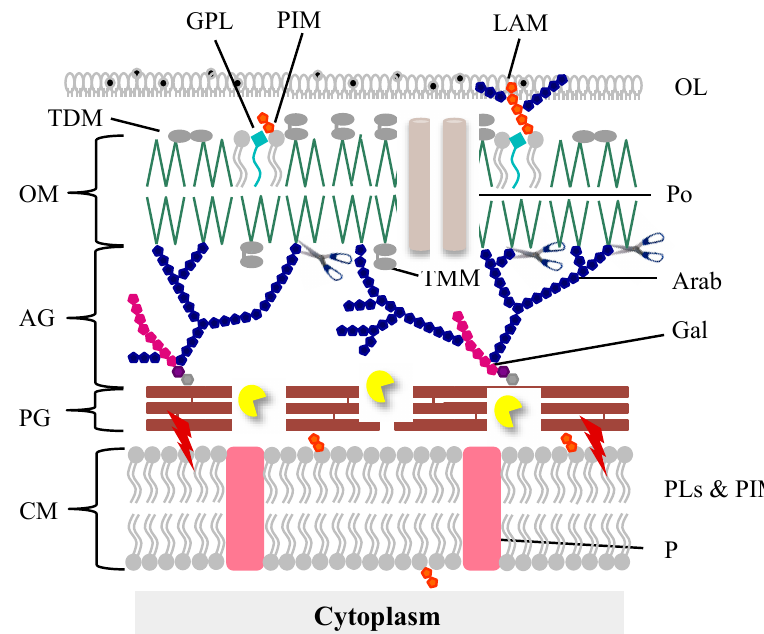
Figure 1. Schematic illustration of the mycobacterial cell envelope layers. The lysis proteins targets are indicated as follows: the red lightning bolts illustrate membrane depolarization by holins; the pacman cartoon represents digestion of the PG by the endolysins; scissors illustrate LysB detachment of the OM. AG, arabinogalatan; Arab, arabinan; CM, cytoplasmic membrane; Gal, galactan; GLP, glycolipids; LAM, lipoarabinomannan; OL, outer layer; OM, outer membrane; P, protein; PG, peptidoglycan; PIMs, phosphatidylinositol mannosides; PLs, phospholipids; Po, porin; TDM, trehalose dimycolate; TMM, trehalose monomycolate.